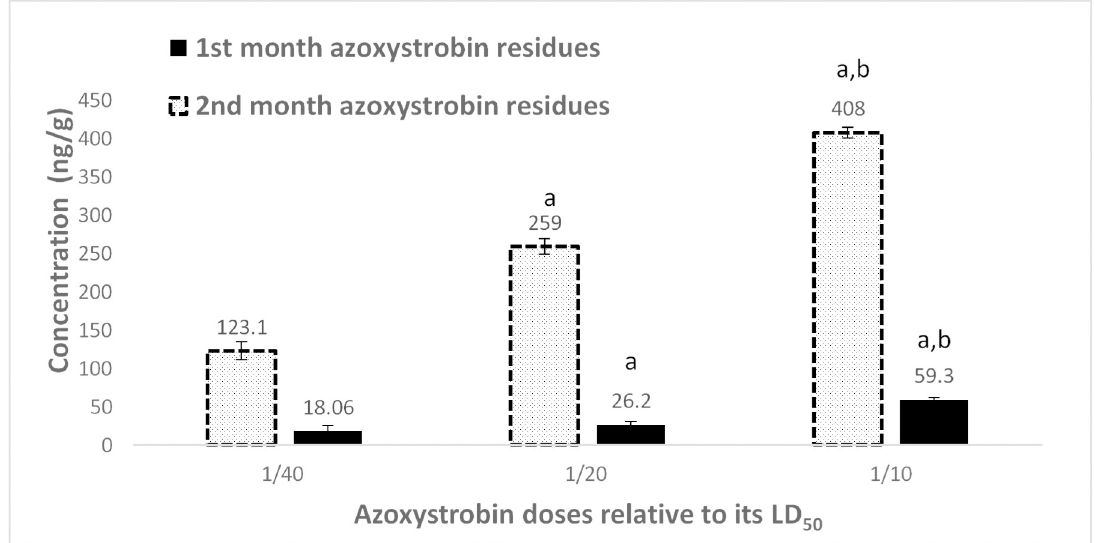
Fig 11. Liver azoxystrobin residues after 1 and 2 months treatment with different doses of azoxystrobin on male rats. Data presented as mean S.E. a Significant difference as compared to 1/40 LD 50 , and b significant (n = 4, P � 0.05).